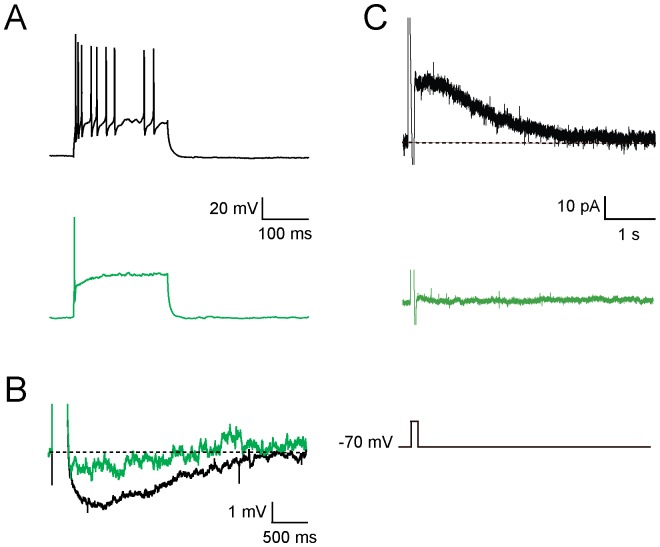
EGFP-expressing neurons do not show a slow afterhyperpolarization.A. A train of action potentials fired by a mature granule cell (black, top) demonstrating spike-frequency adaptation. Most immature EGFP-expressing granule cells do not fire trains of action potentials in response to suprathreshold current injections. B. Voltage traces elicited in response to a large current injection for EGFP-expressing dentate gyrus granule cells (green) and a mature dentate gyrus granule cell (black), demonstrating the slow AHP is not present in immature granule cells. C. The slow AHP can also be seen in the outward current trace in response to a voltage step to 0 mV (bottom trace) for mature granules cells (black, top) but is absent in the immature cells (green, middle).